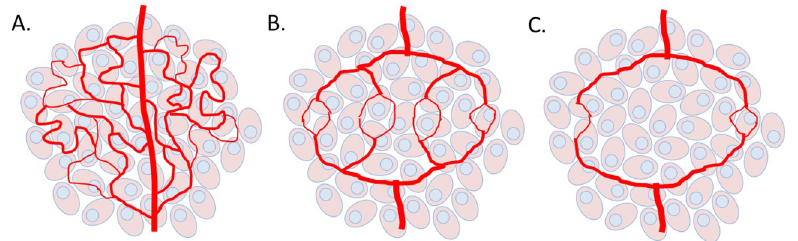
Fig 1. Cases of tumour vascularization. In A. the tumour is overvascularized with chaotic, irregular vessels ( m > 1) causing perfusion-limited hypoxia. In B. vascular normalization ( m � 1) is achieved where optimal oxygen or drug extravasation is realized. In C. a strong dose of AAs causes vascular destruction ( m < 1), leading to diffusion-limited hypoxia in the tumour. The quantity m is the tumour blood vessel